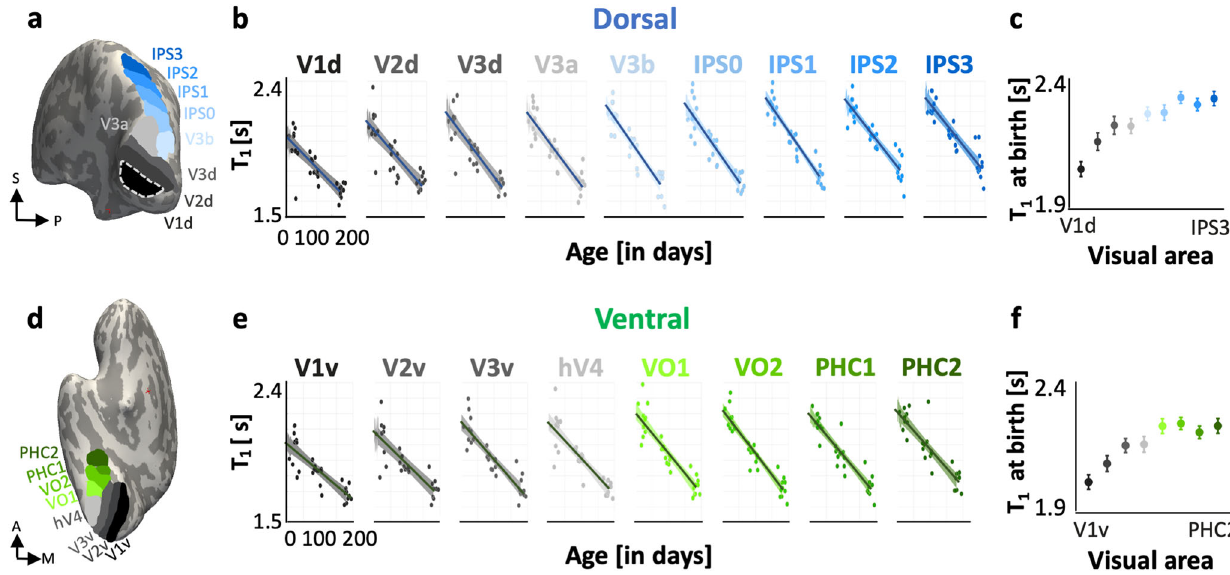
Fig. 2 Hierarchical development of cortical microstructure in visual streams. a , d In fl ated cortical surface of an example 6-month-old infant showing nine dorsal ( a ) and eight ventral ( d ) visual areas 34 . b , e T 1 as a function of infant age in each visual area of dorsal ( b ) and ventral ( e ) visual processing streams. The color indicates the visual area (see a , d ). Each dot: mean T 1 per area per infant. Solid lines : Linear mixed model (LMM) estimates of T 1 development for each visual area. Shaded portions represent 95% con fi dence intervals. c , f LMM estimates of mean T 1 at birth (LMM intercept) in each dorsal ( c ) and ventral ( f ) visual area. Error bars: standard error on estimates of intercepts. Data shown are of the right hemisphere. Left hemisphere data are shown in Supplementary Fig. 5. For panels b , e , N total = 30, 10 infants at each time point (newborn, ~3-month-old,